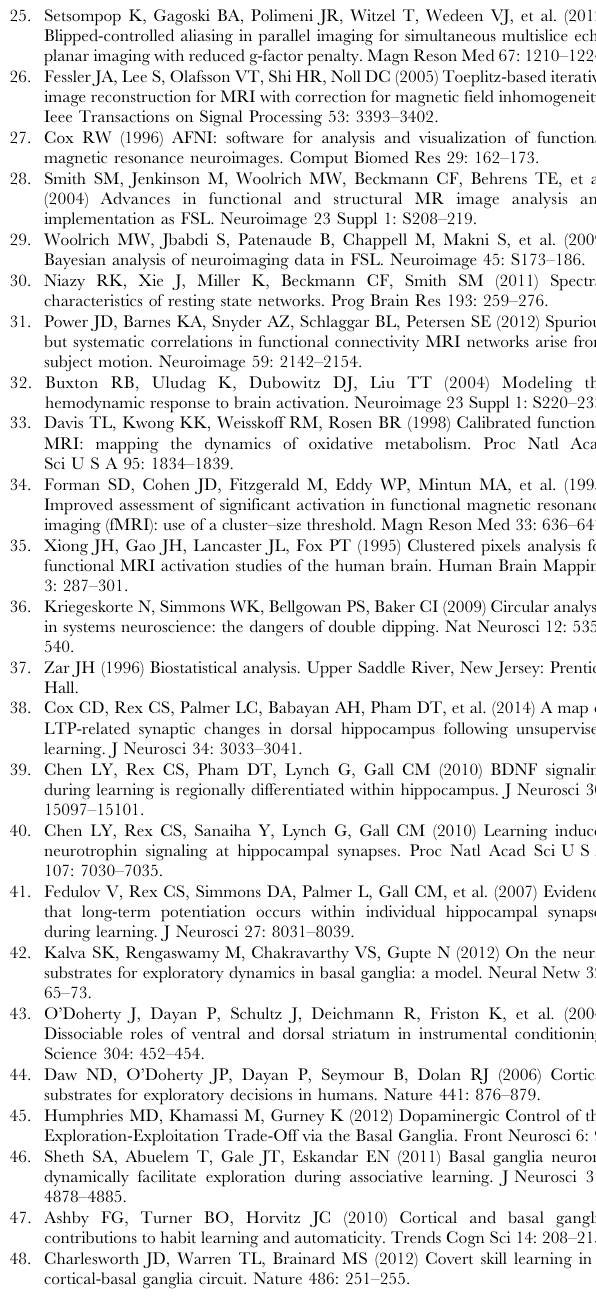
Figure S2 BOLD signal variability (calculated using the averaged BOLD signal within each significant cluster) versus performance score plotted for the significant clusters identified in Table 2.